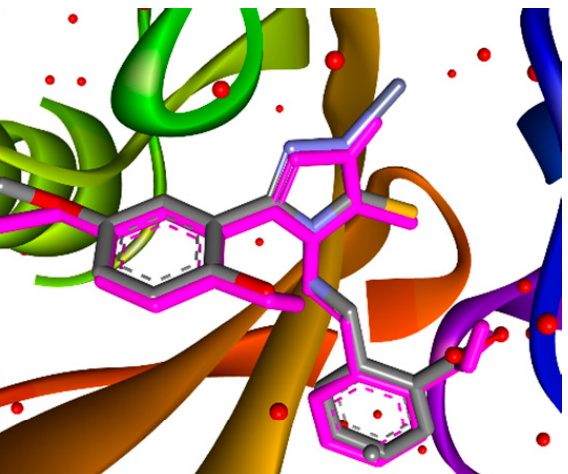
Figure 3. Real and predicted (pink-colored) position of the PJQ inside MBL (PBD 6YRP).